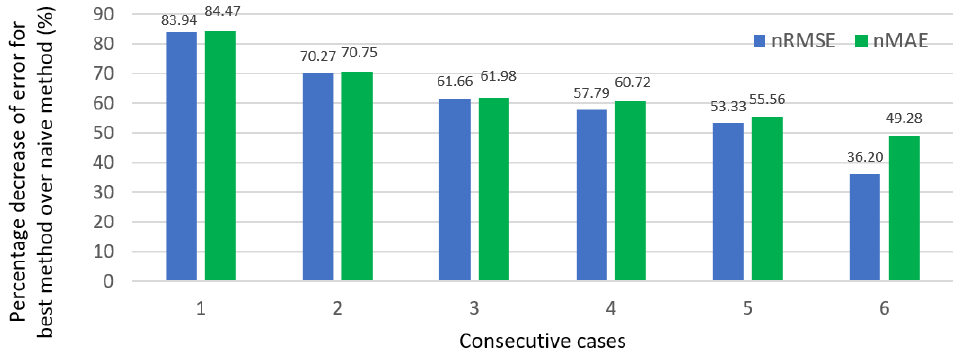
Figure 17. Percentage improvement of the best method relative to the naive method for nRMSE and nMAE error metrics.